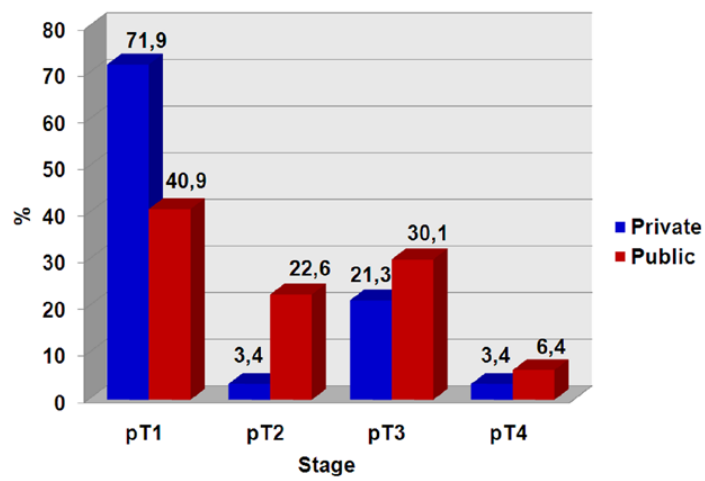
Figure 1 - RCC pathological staging according to the source